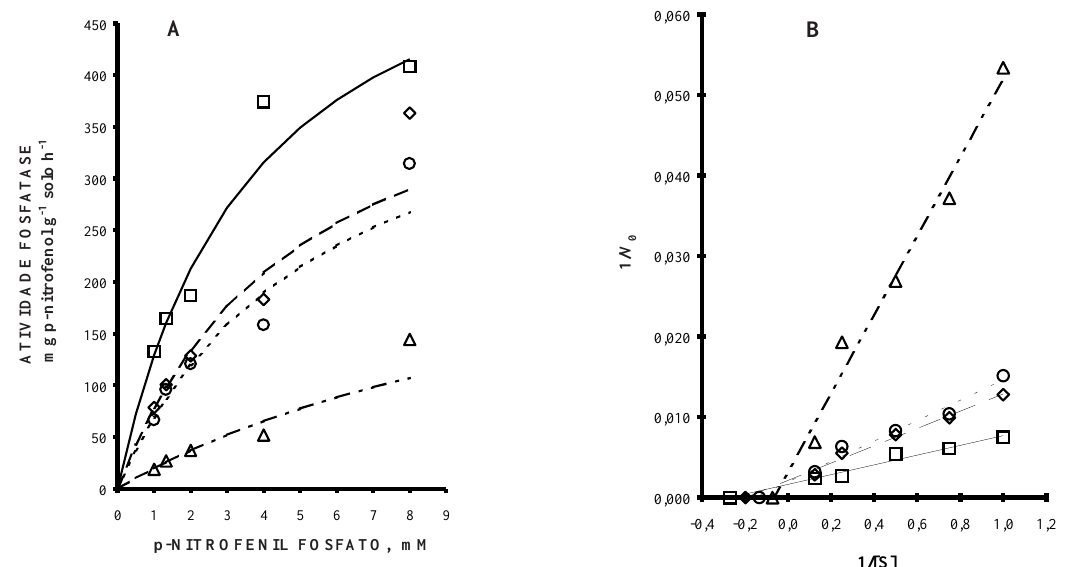
percentuais)Figura 3. Resposta de fosfatases ao incremento das concentrações de substrato, em solo com